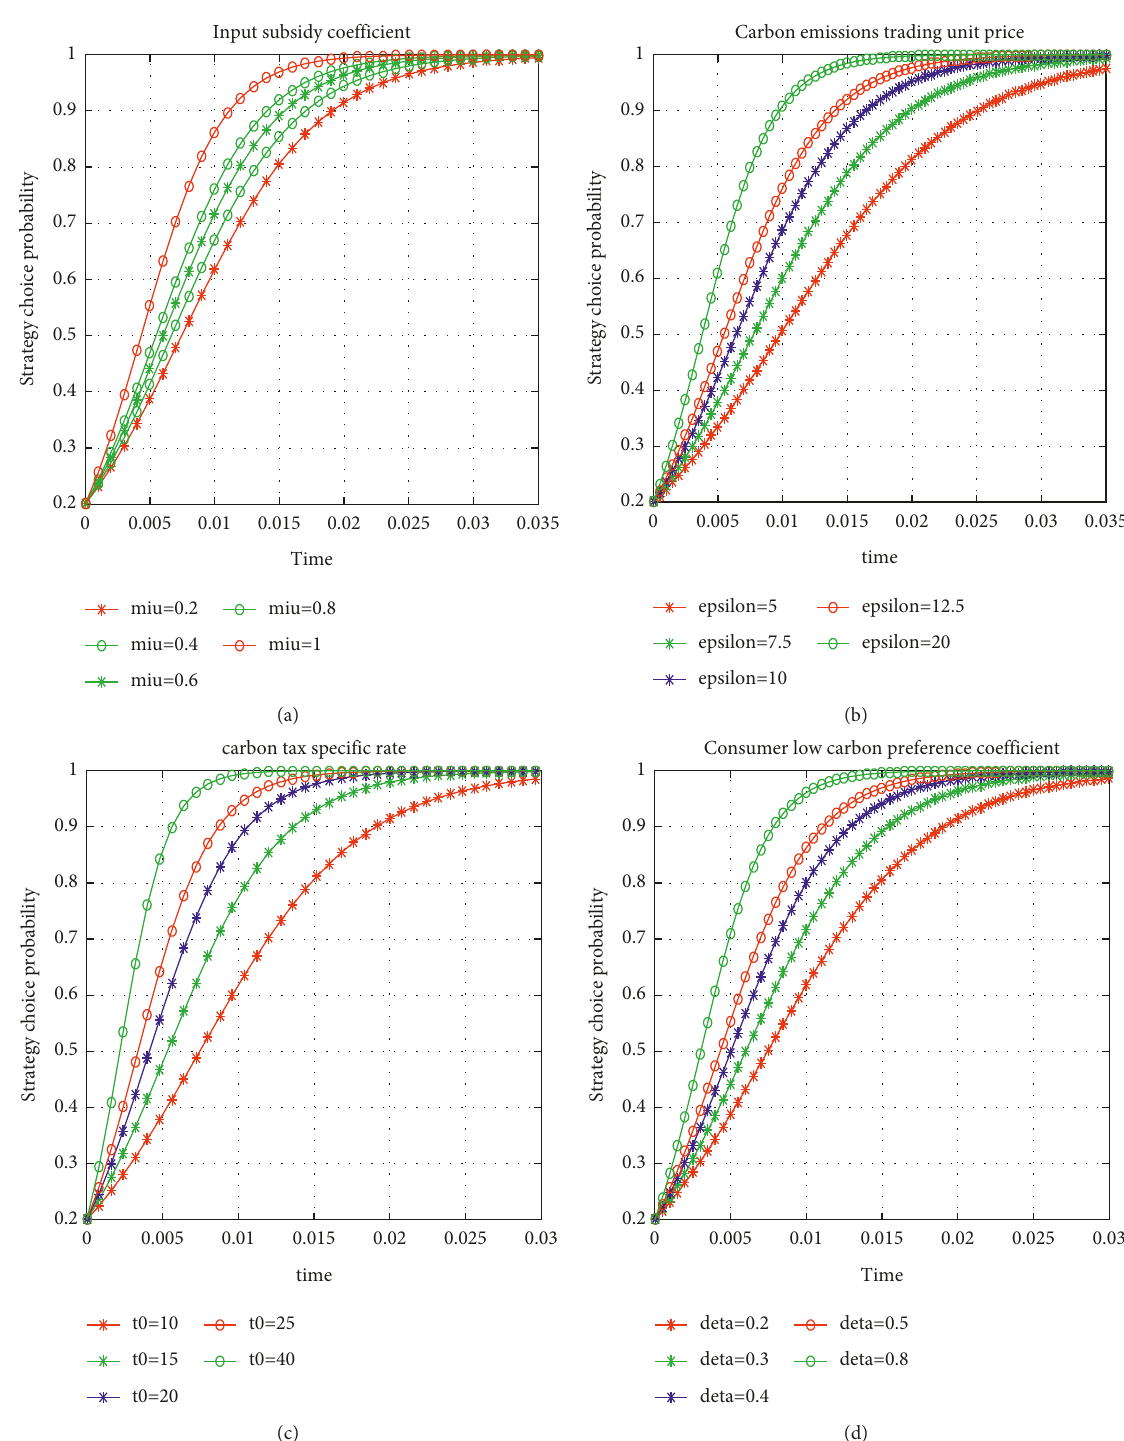
Figure 4: Enterprise behavior strategy under different parameter